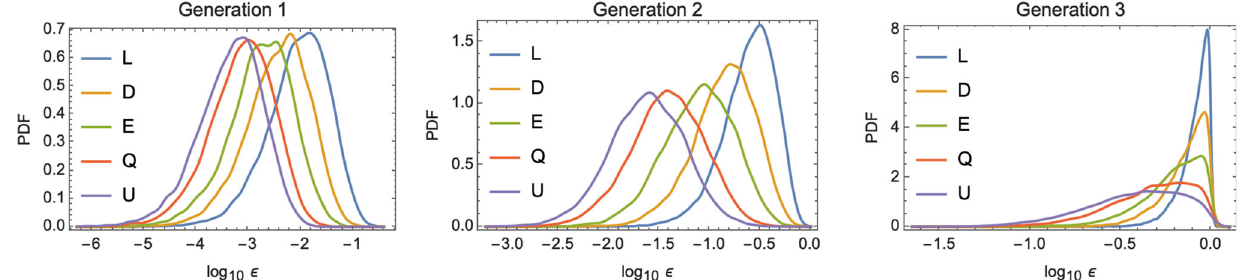
Fig. 4 One dimensional distribution of eigenvalues of the E X matrices for SO ( 10 ) with N = 5, a = 0 . 5, tan α = − 0 . 6, and b = 1 . 4